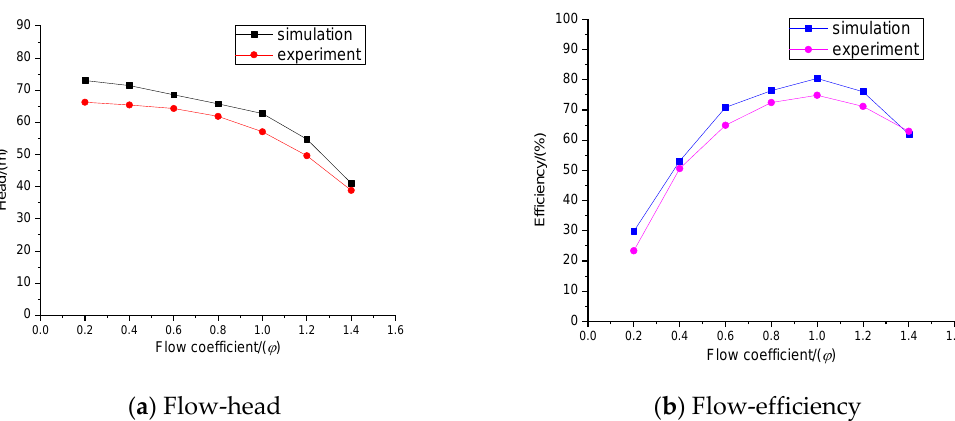
Figure 5. Comparison of experimental and simulation results for pump head and efficiency.